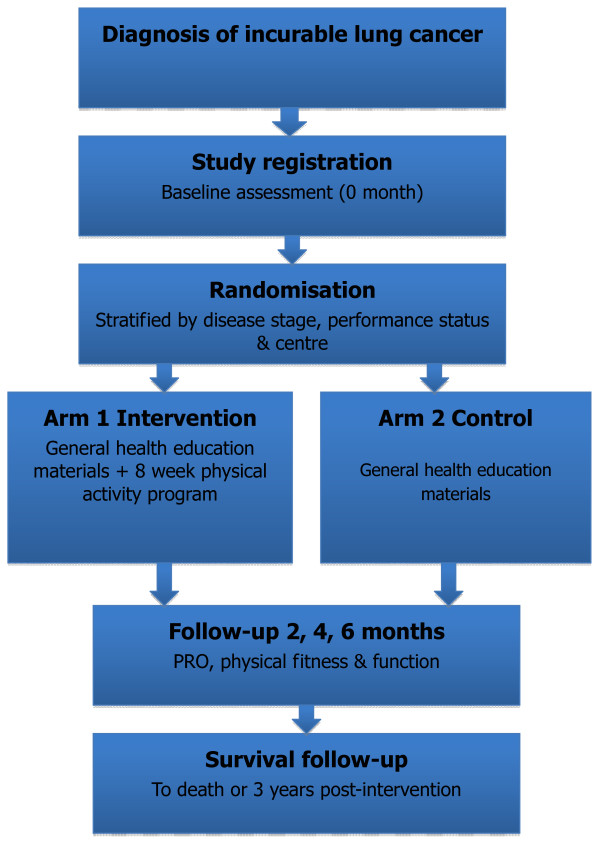
Study flowchart. PRO = patient reported outcomes.